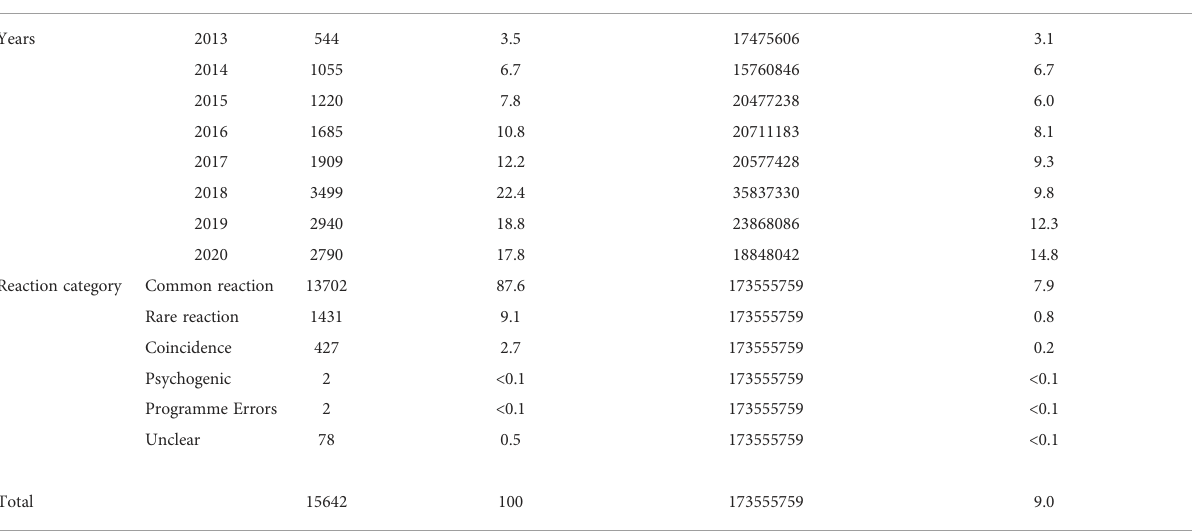
TABLE 1 Rates of AEs after Hep-B vaccination by years and reaction category.